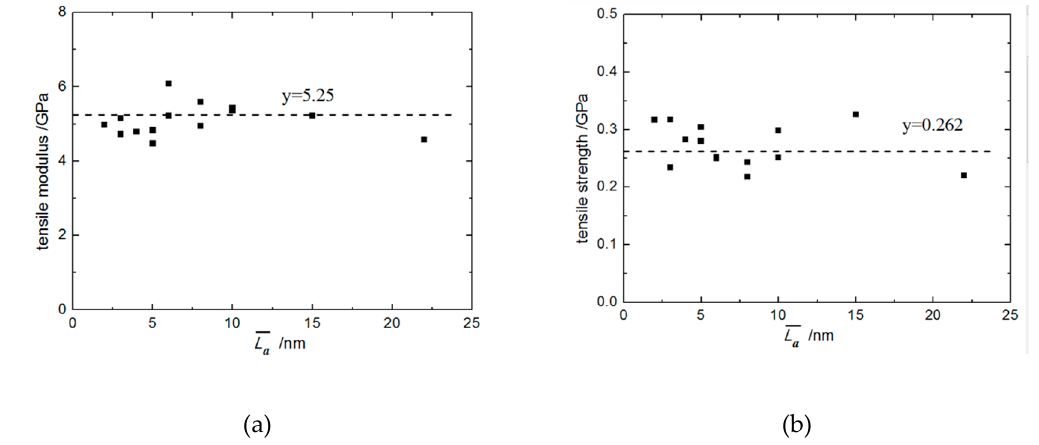
Figure 6. The normal tensile mechanical properties of the C f /PyC interphase with different sizes of L a : ( a ) Modulus; ( b ) Strength.